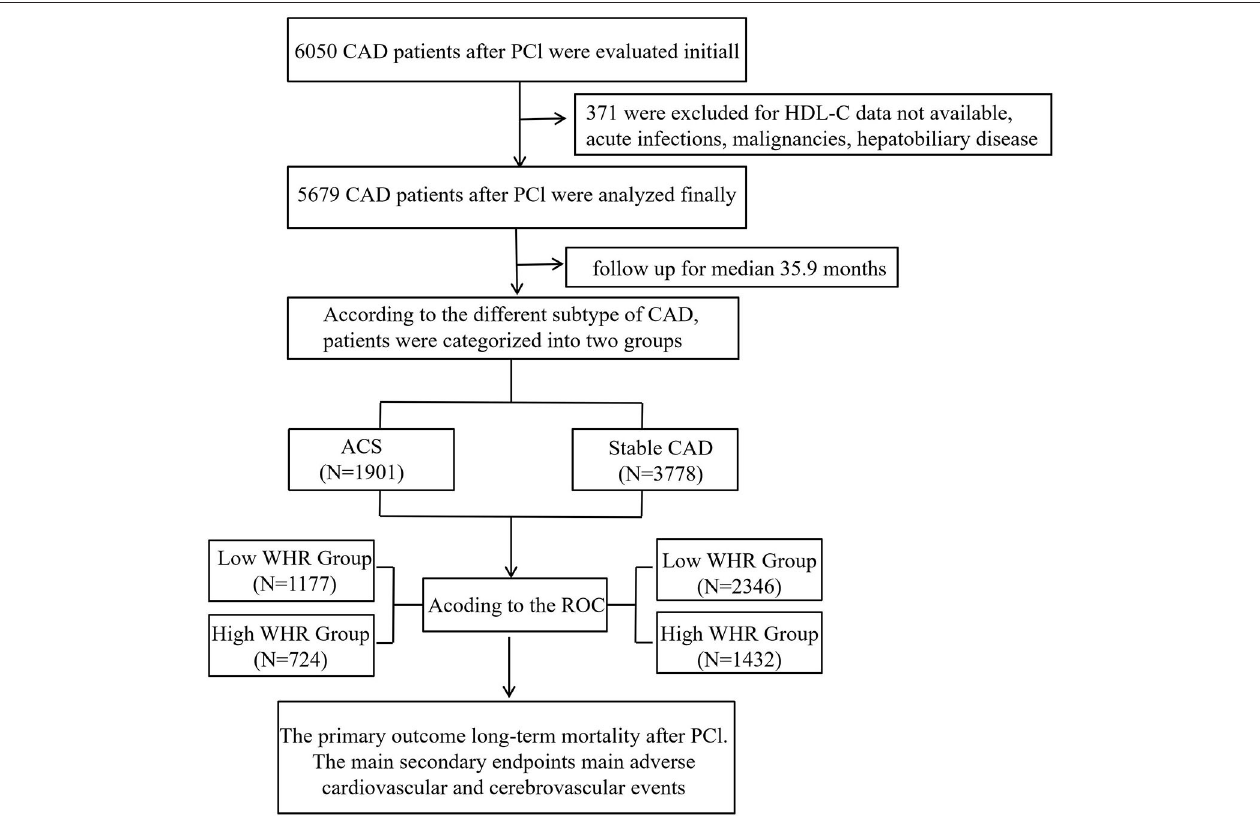
FIGURE 1 | The follow chart of participants